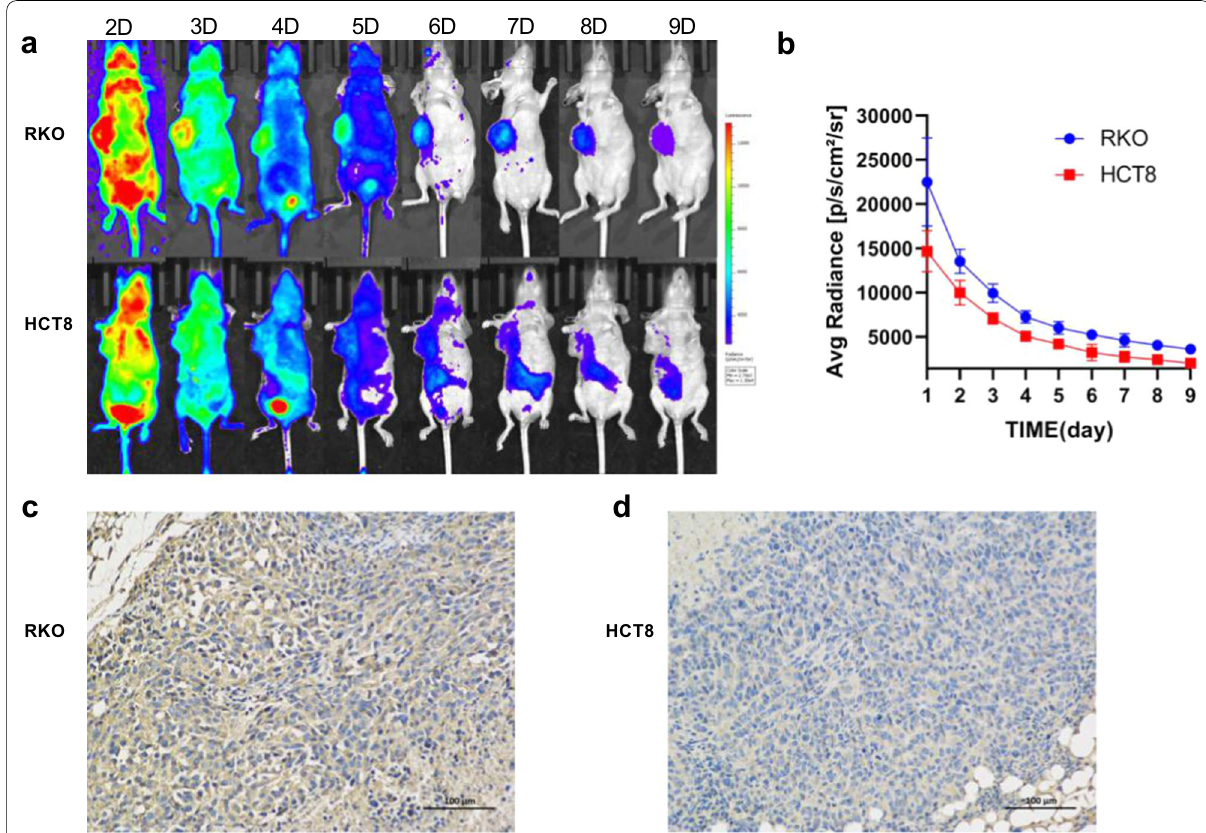
Fig. 2 CLI and immunohistochemistry. a CLI of 131 I-Atezolizumab in RKO model and HCT8 model at each time point. b Quantification of the average fluorescence intensity of CLI. c , d Immunohistochemical images of RKO model and HCT8